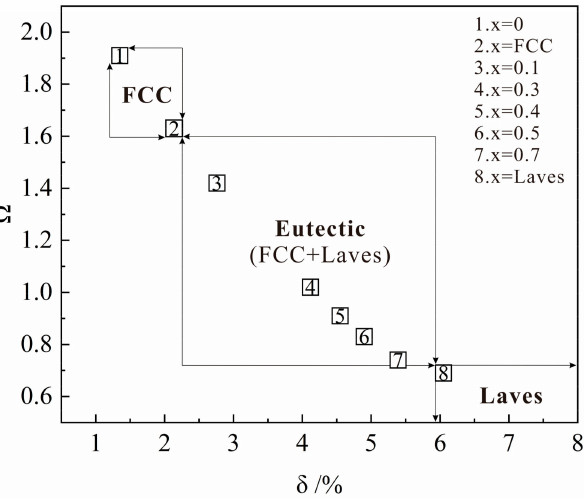
Figure 4. Relationship between Ω and atomic size difference δ indicating the evolution of FCC, eutectic, and Laves regions.